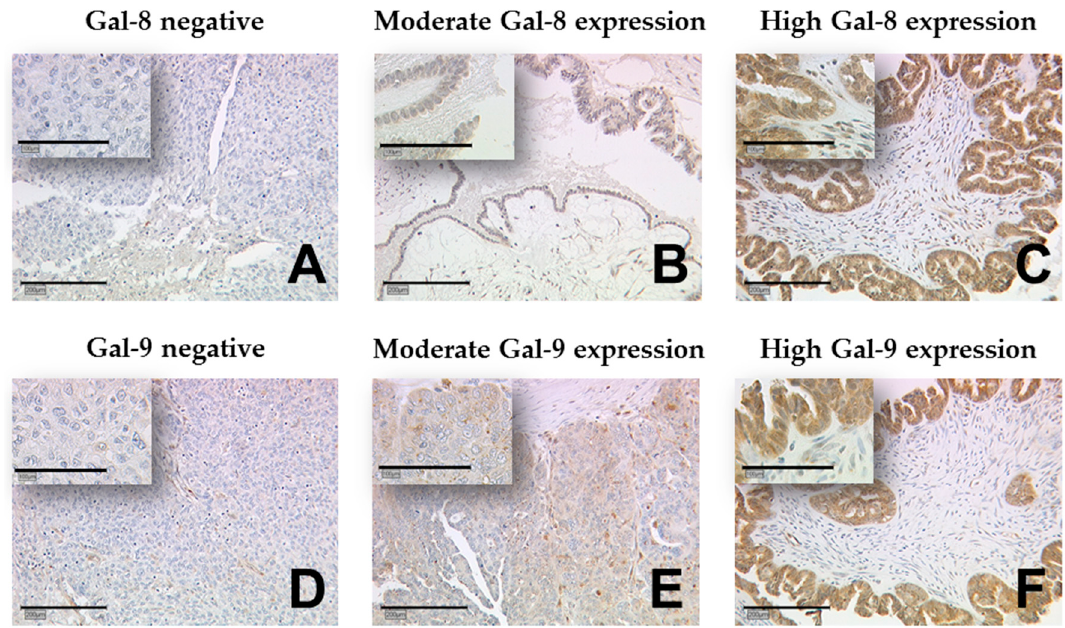
Figure 1. Detection of galectin-8 and -9 using immunohistochemistry (IHC). Gal-8 staining ( A – C ) and Gal-9 staining ( D – F ) was predominantly present in the cytoplasm of ovarian cancer cells but not in the peritumoral stroma. Representative photomicrographs are shown. There is a 10× magnification for the outer pictures and 25× for the inserts. Scale bar in ( A ) equals 200 μ m (outer pictures) and 100 μ m (inserts). Gal: galectin.